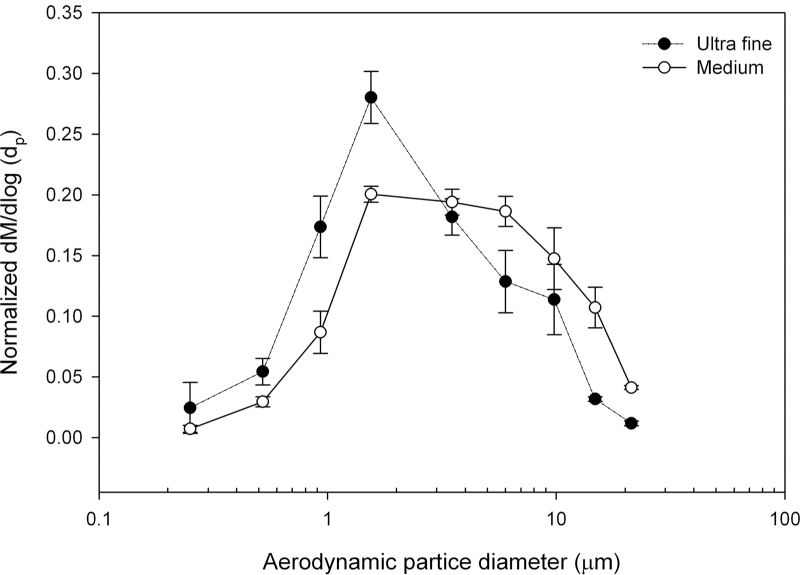
Particle size distribution of aerosolised ARD test dust.